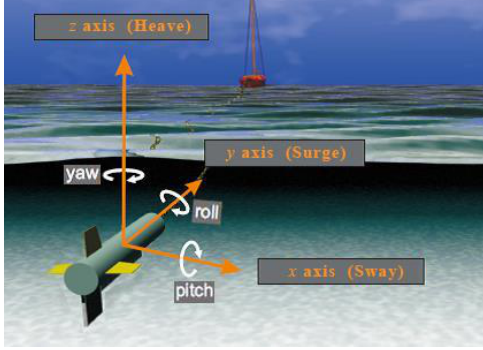
Figure 2. The motion error of the sonar system.